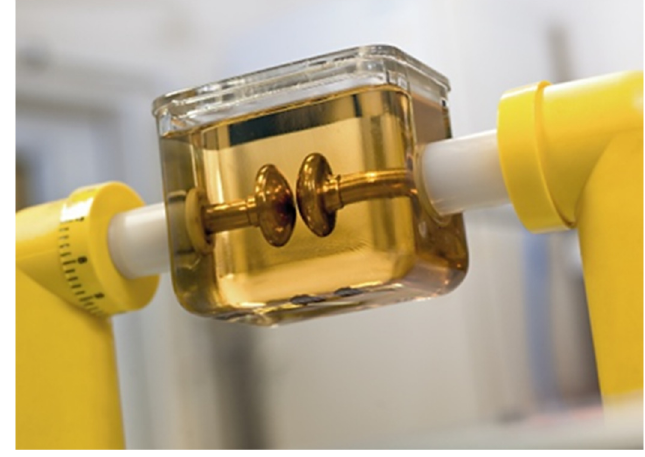
Figure 13. Dielectric breakdown voltage measurement test [57].